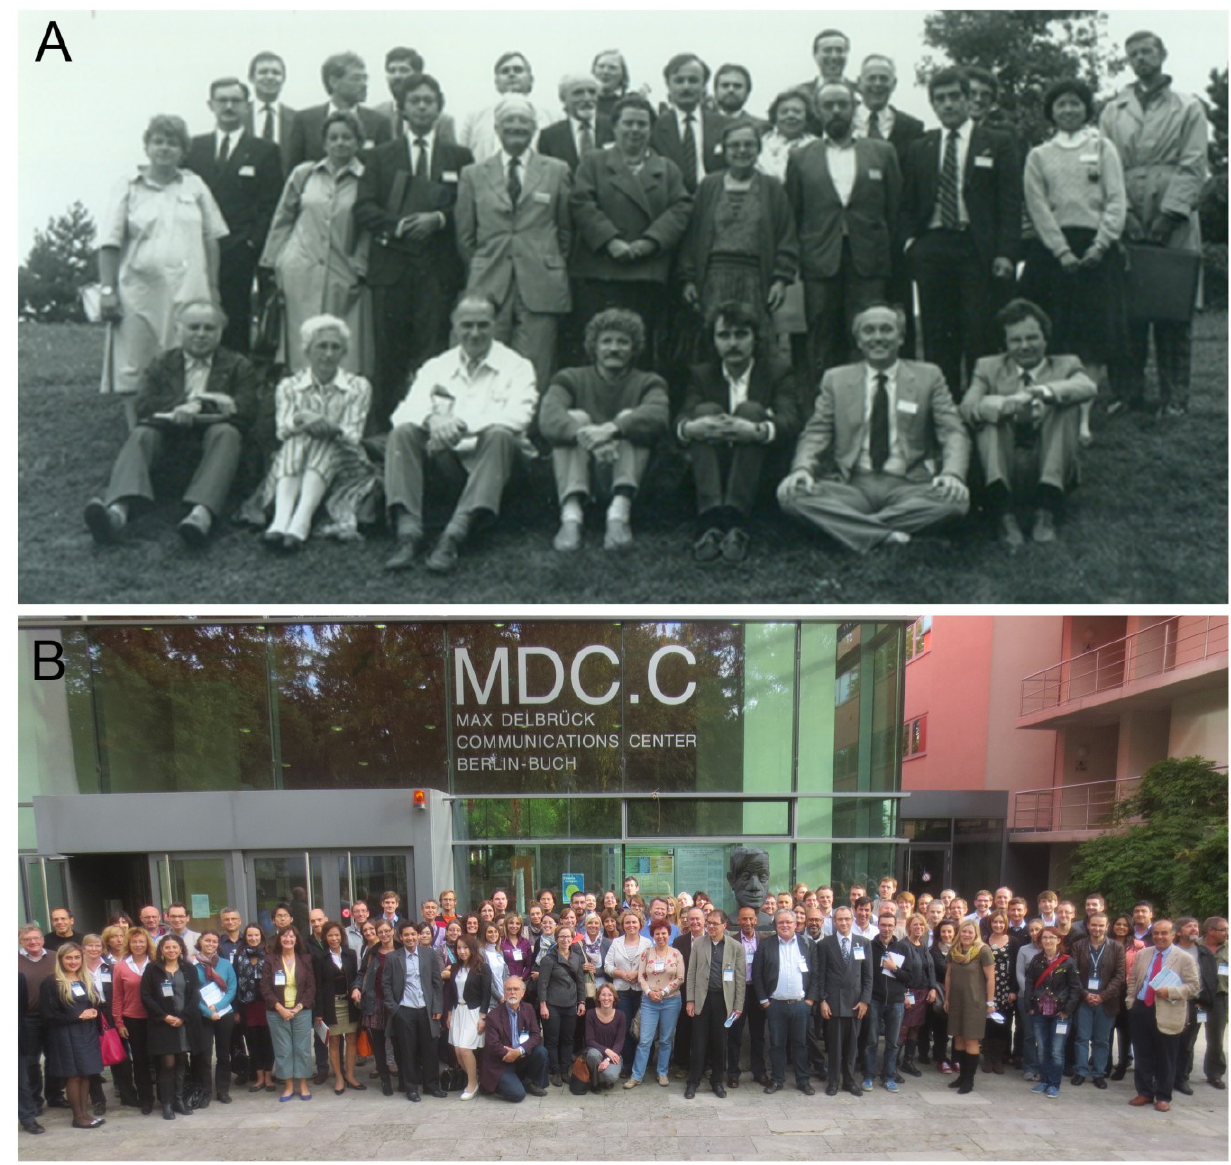
Figure 1. The Working Group then and now. ( A ) The Embryology and Teratology WG meeting in Gottingen, Septmber 1986. ( B ) The Development, Anatomy and Embryology WG meeting in Berlin, September